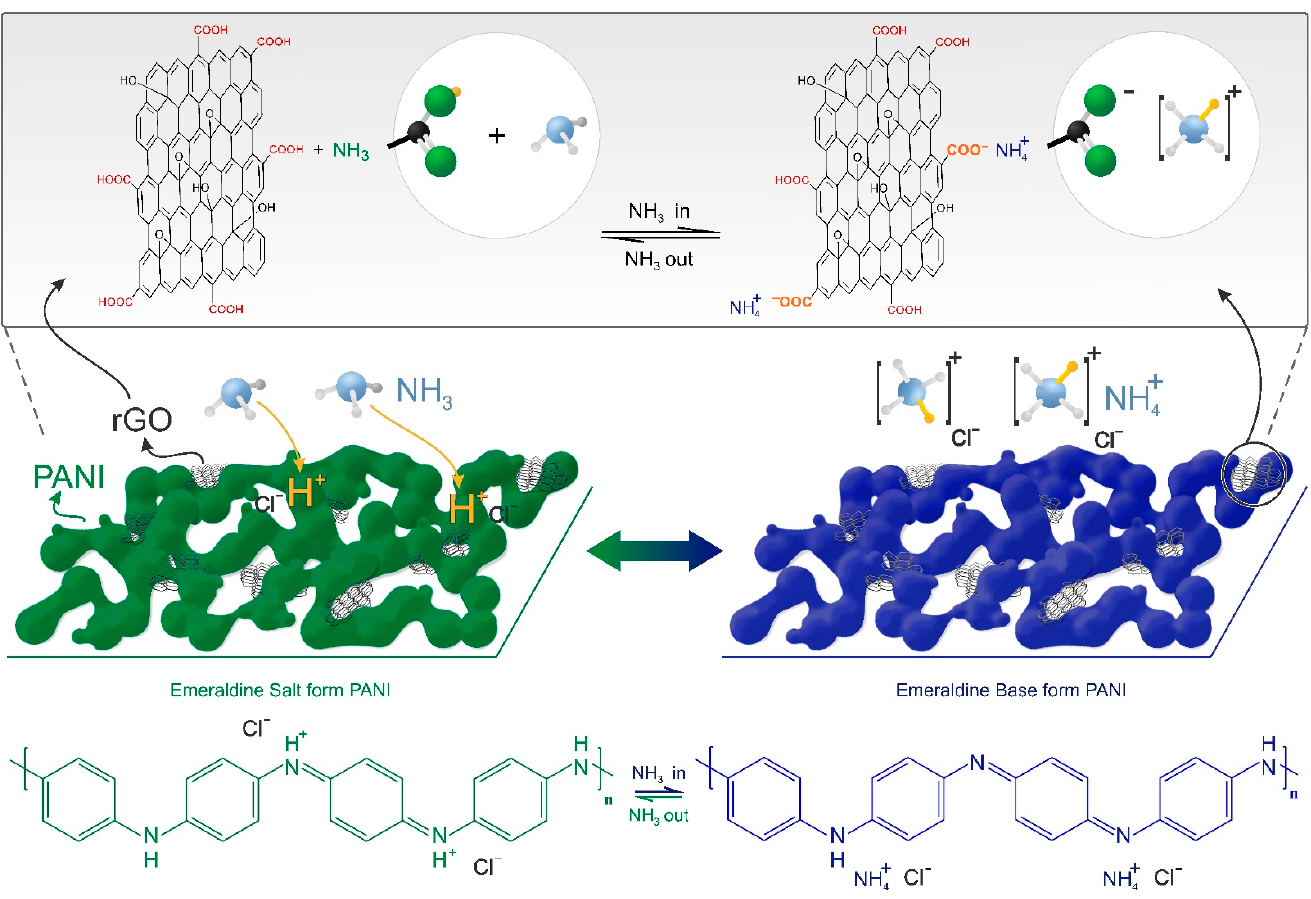
Figure 1. NH 3 protonation/deprotonation process in PANI chains and rGO sheets.